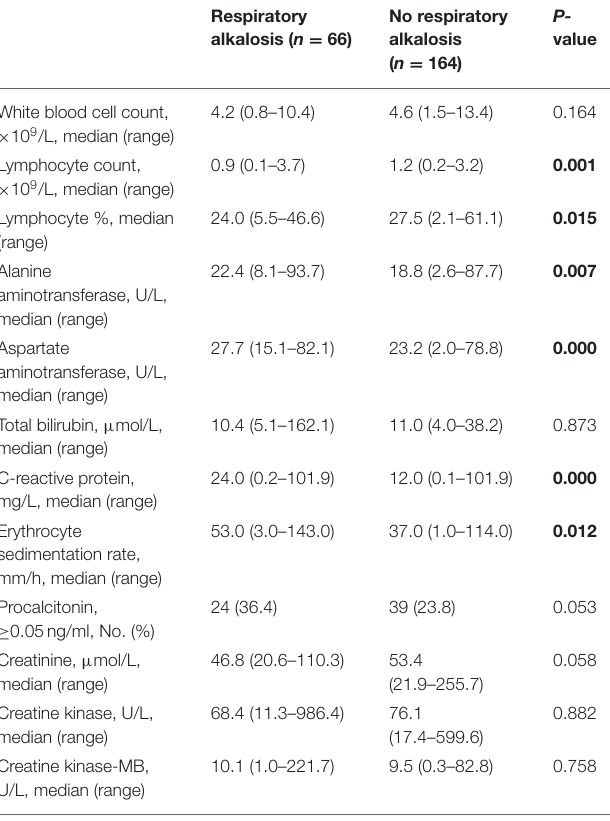
TABLE 2 | Laboratory findings of COVID-19 patients with or without respiratory alkalosis.